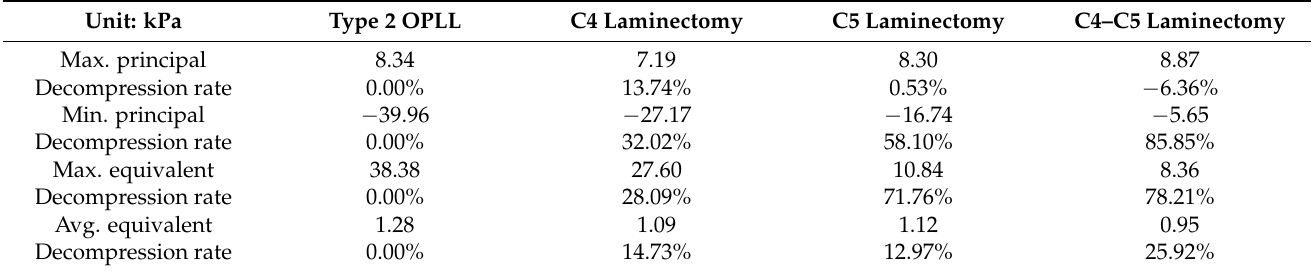
Table 11. Extension laminectomy simulation spinal cord stresses: type 2 OPLL.